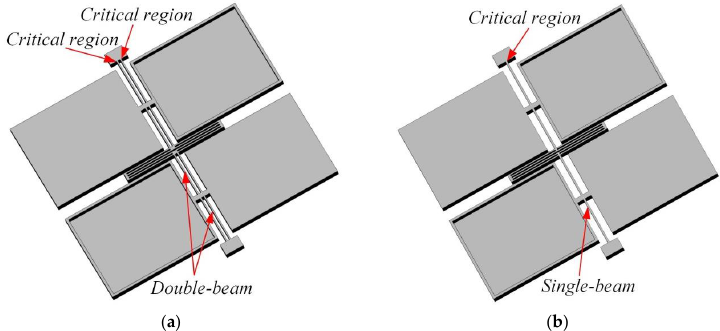
Figure 7. The simulation models of two accelerometers: ( a ) Simulation model of double-beam torsional accelerometer; ( b ) Simulation model of single-beam torsional accelerometer.